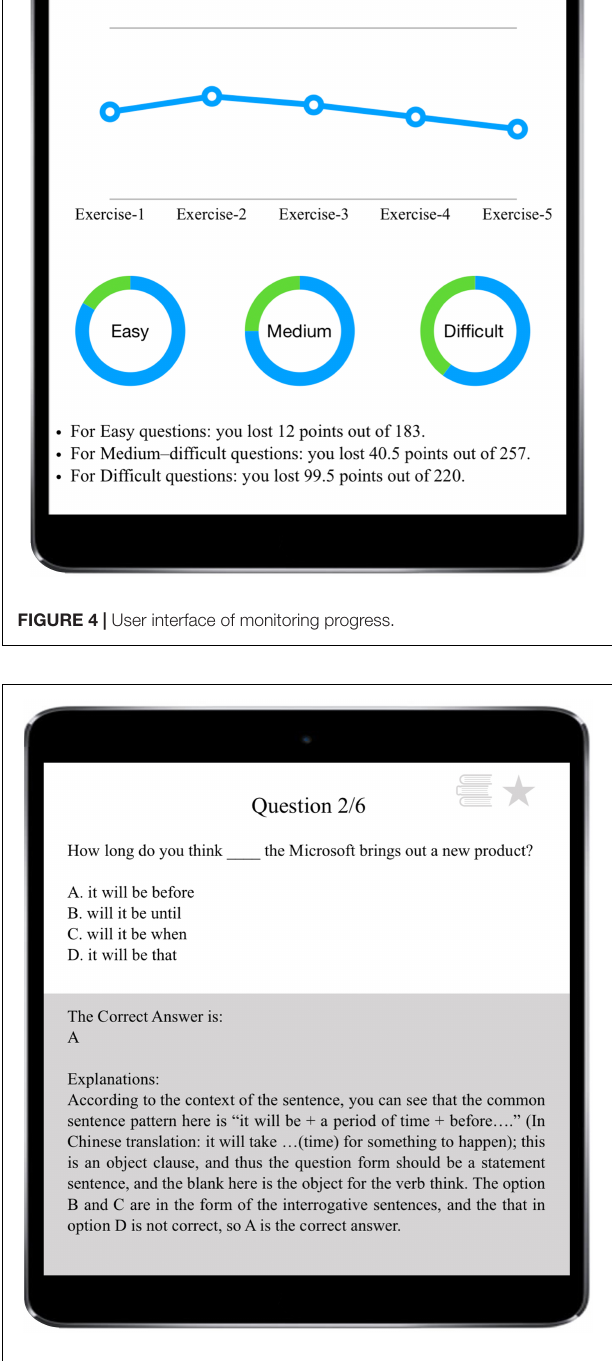
FIGURE 5 | User interface of detailed